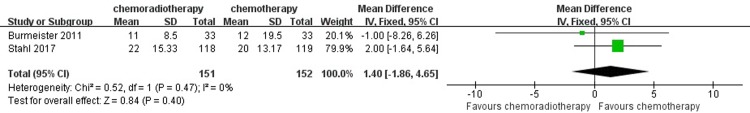
Forest plot of the included studies for hospital stay.M-H, Mantel-Haenszel.